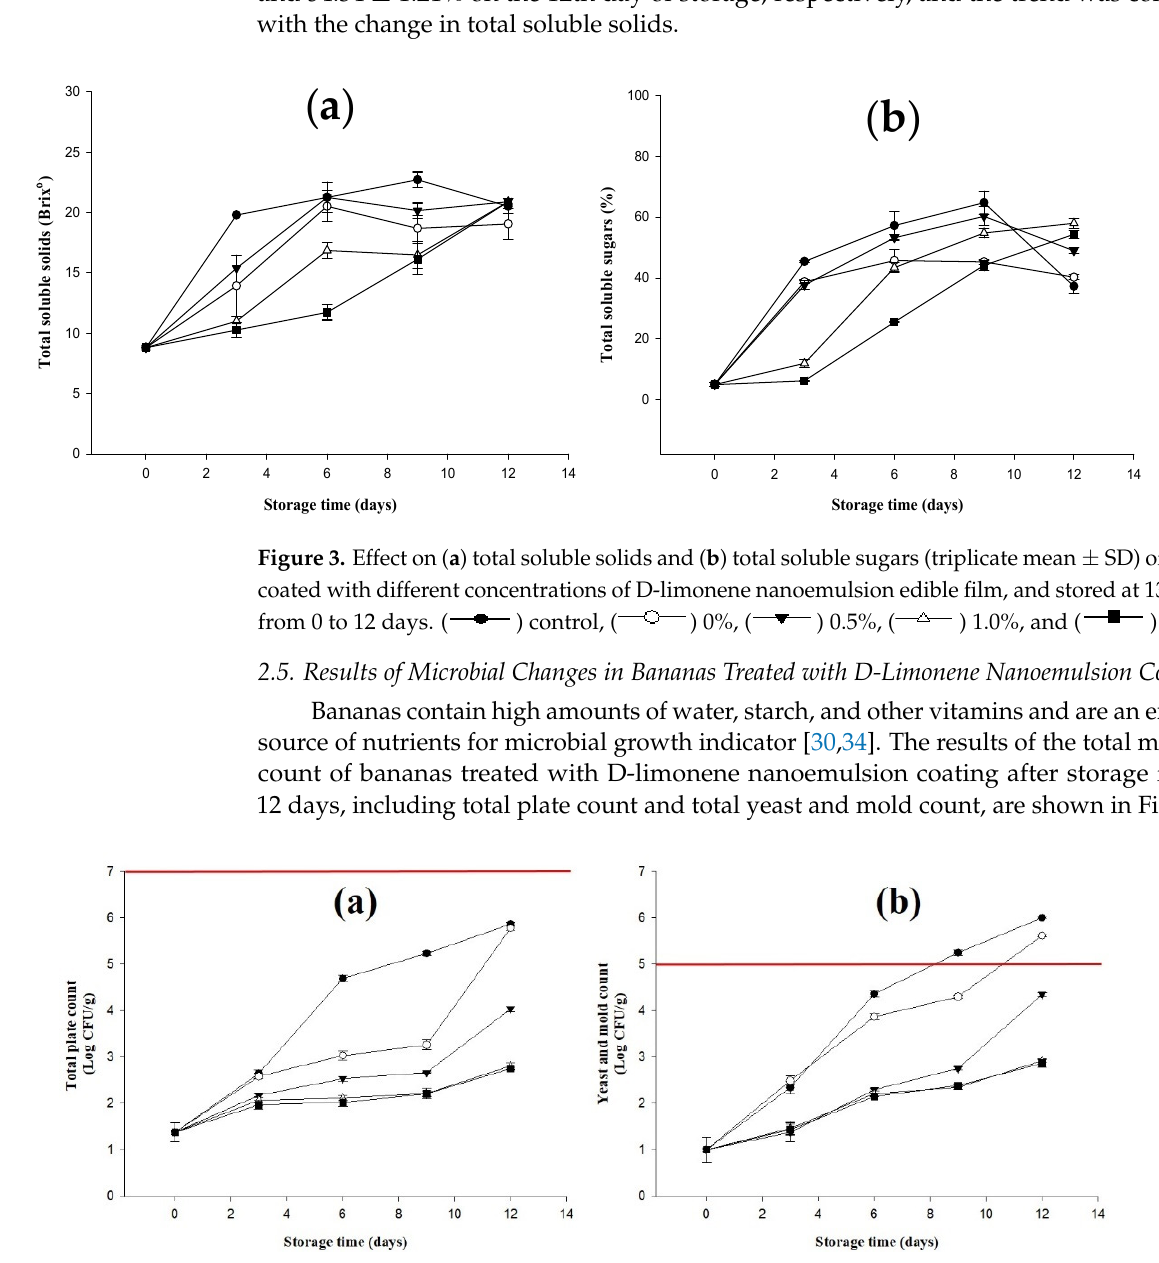
Figure 2. Effect on ( a ) weight loss, ( b ) firmness, ( c ) pH, and ( d ) titratable acidity (triplicate mean ± SD) of bananas coated with different concentrations of D-limonene nanoemulsion edible film and stored at 13 ± 1 °C from 0 to 12 days. ( ) control, ( ) 0%, ( ) 0.5%, ( ) 1.0%, and ( ) 1.5%.